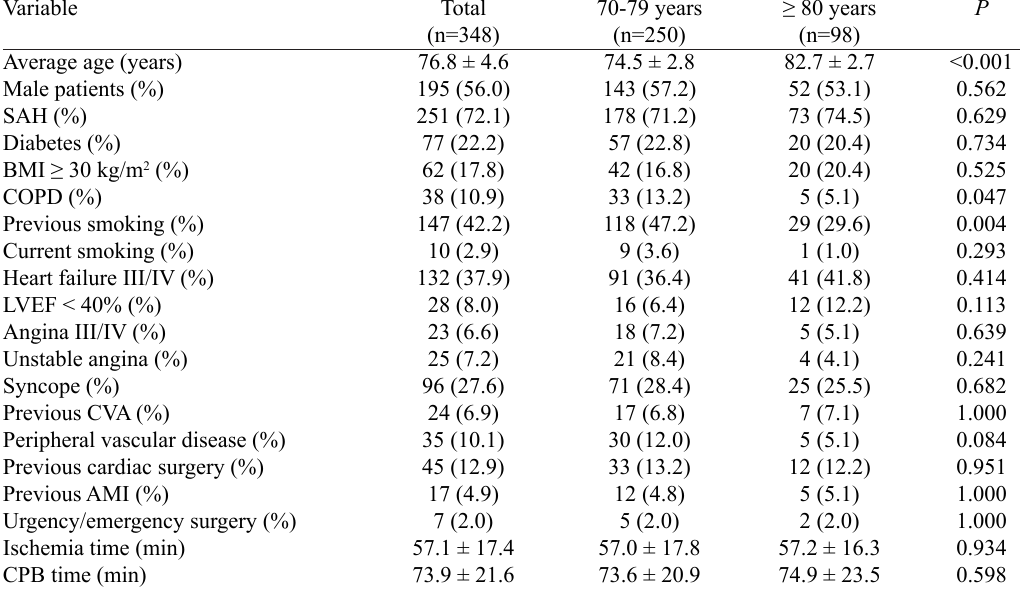
Table 1. Demographic characteristics of the studied population.